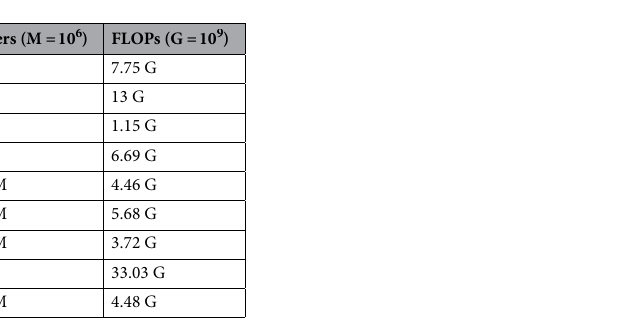
Table 7. Computational complexity comparison of